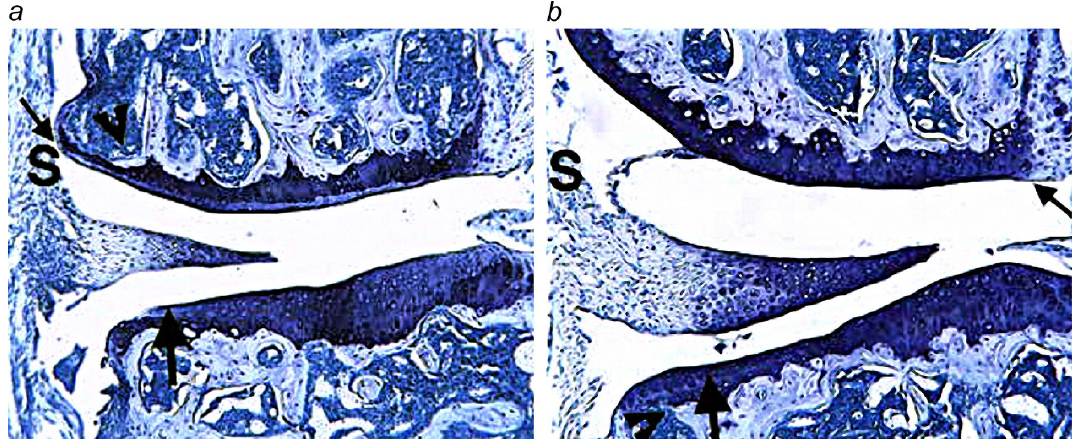
Figure 7. MT-SYK-03 alleviates inflammation and cartilage damage in murine CIA. Frontal section, 100 × magnification. a . The knee from a vehicle control animal reveals moderate inflammation (S) and marked cartilage damage (large arrow) with very minimal pannus (small arrow) and bone resorption (arrowhead). b . The knee from an arthritic animal treated with 103 mg/kg of MT-SYK-03 has very minimal inflammation (S) and minimal cartilage damage (large